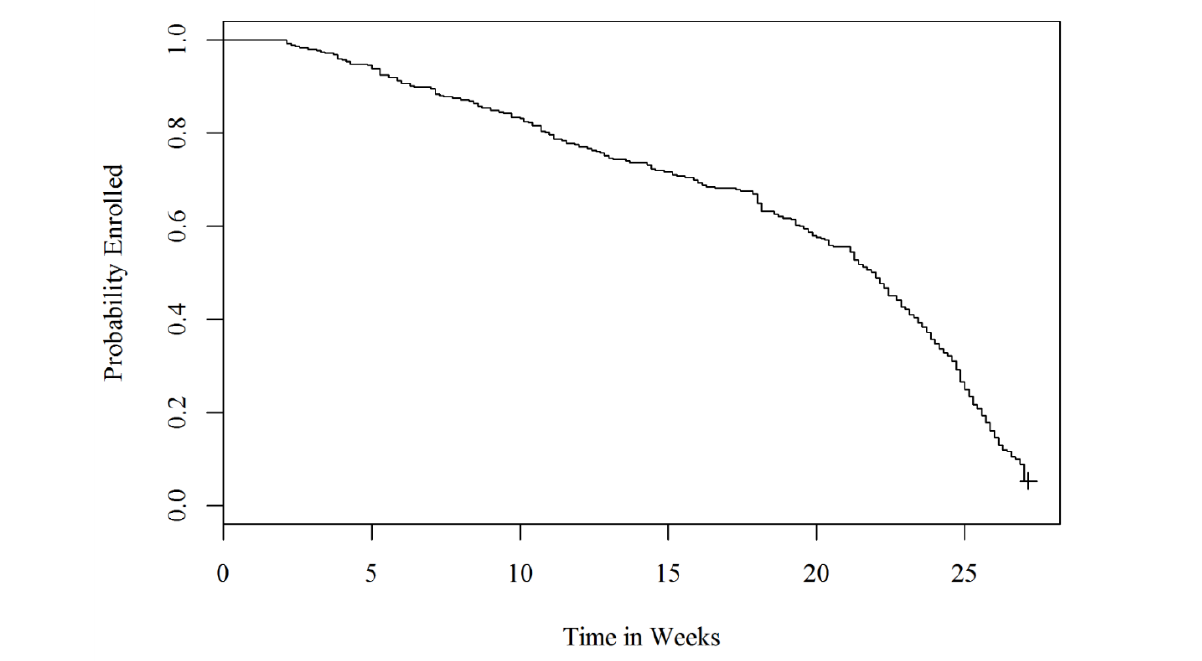
Figure 1. Kaplan-Meier estimate of probability of duration of mobile data availability over the course of the study.